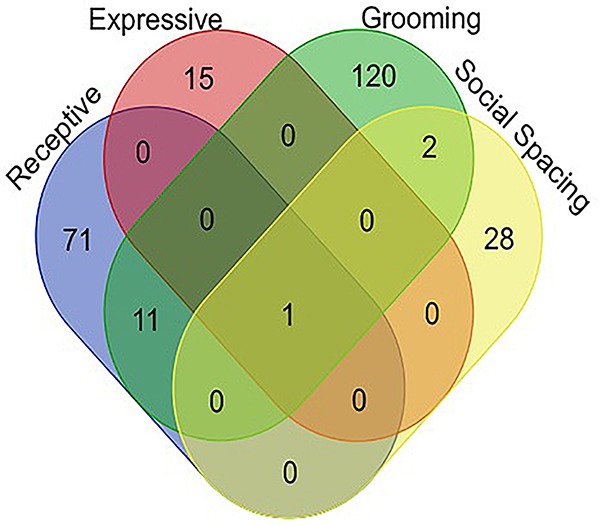
Venn diagram representing all of the significant gene associations for all behaviors measured in 40 DGRP lines. Note that there is only one gene, sfl, that showed significant associations for all four ASD-like behaviors. Raw output for all GWAS studies is available in the Supplementary Data Section.